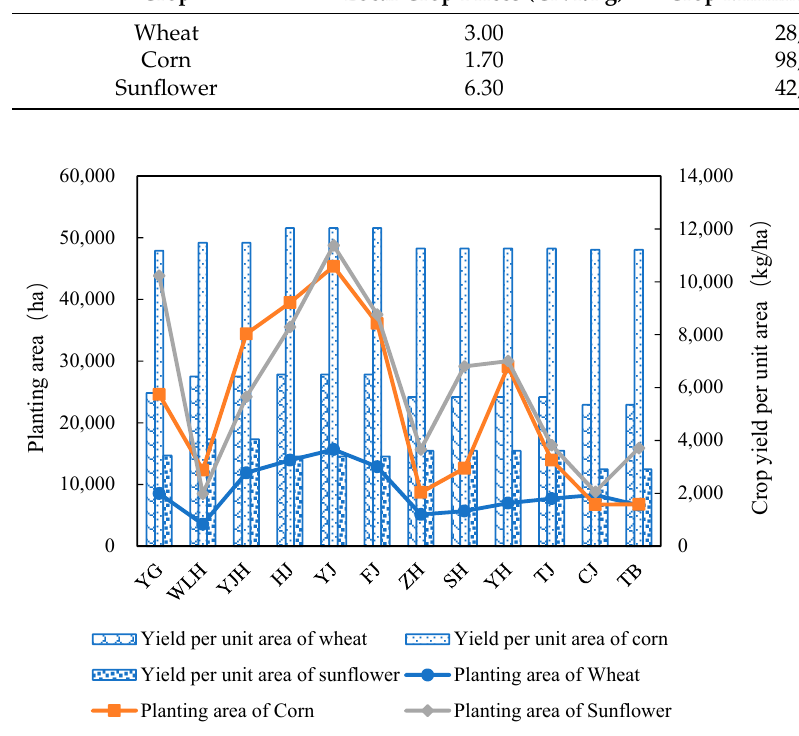
Figure 6. Planting area and maximum yield data of crops in HID.